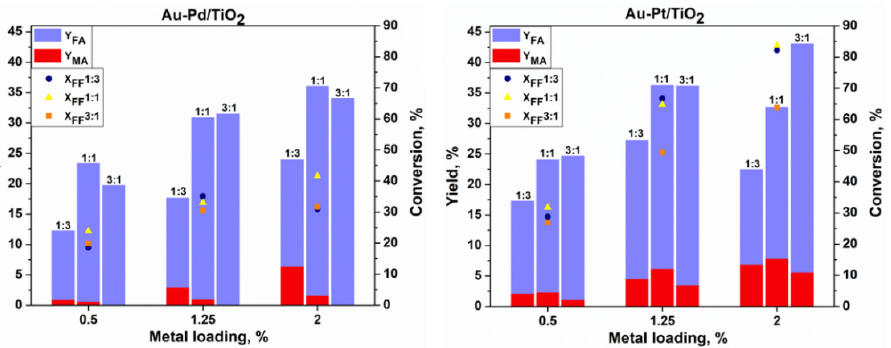
Figure 5. Catalytic results obtained for Au-Pd/TiO 2 and Au-Pt/TiO 2 catalysts in base-free oxidation of furfural (T = 80 °C, t = 4 h, 600 rpm, P(air) = 15 bar).